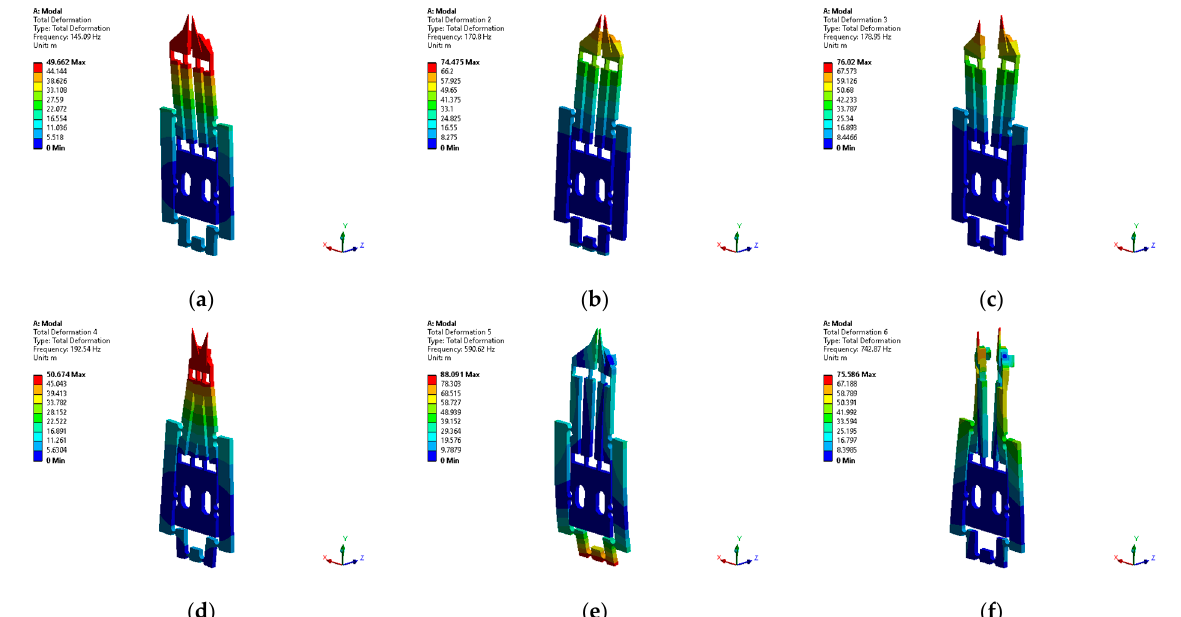
Figure 7. ( a ) First, ( b ) second, ( c ) third, ( d ) fourth, ( e ) fifth, and ( f ) sixth MG modal shapes.